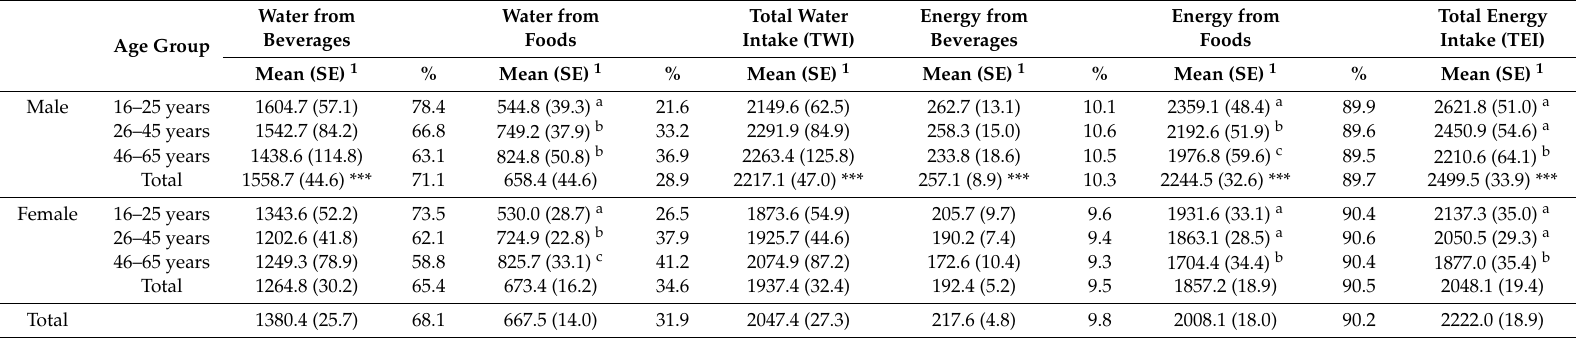
Table 3. Contribution of food and beverages to total water (g/day) and energy (kcal/day) intake by gender and age